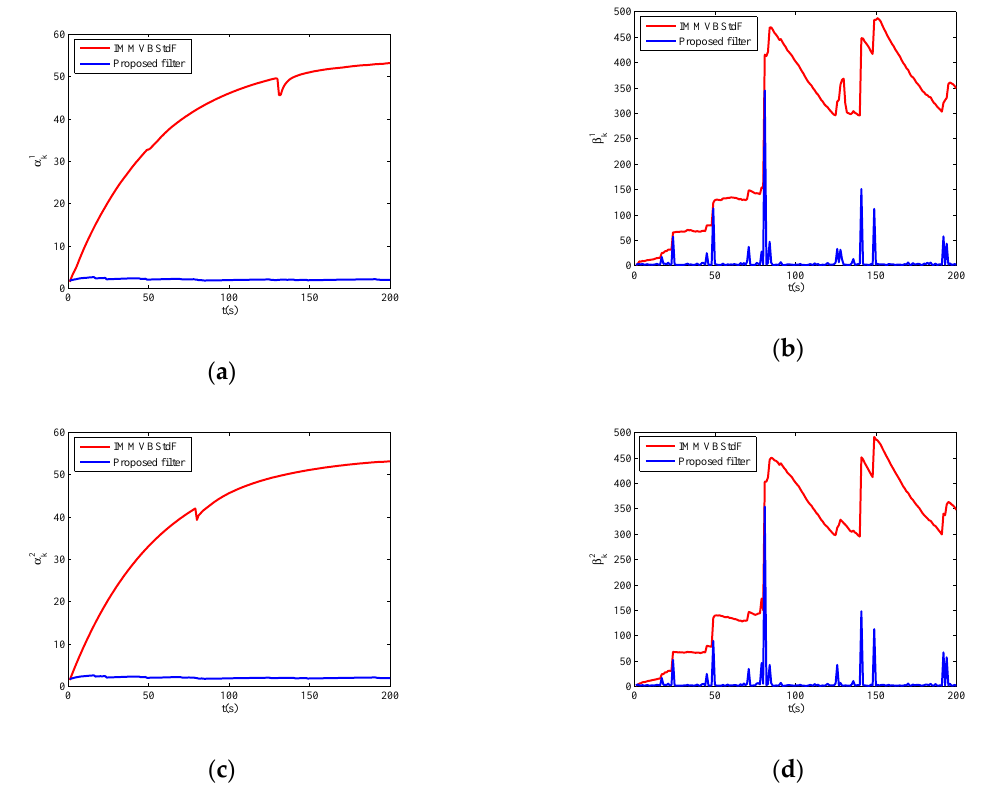
Sensors 2019 , 19 , x FOR PEER REVIEW Figure 6. Estimates of degrees of freedom parameters versus time. ( a ) ˆ α 1 Figure 6. Estimates of degrees of freedom parameters versus time. ( a )